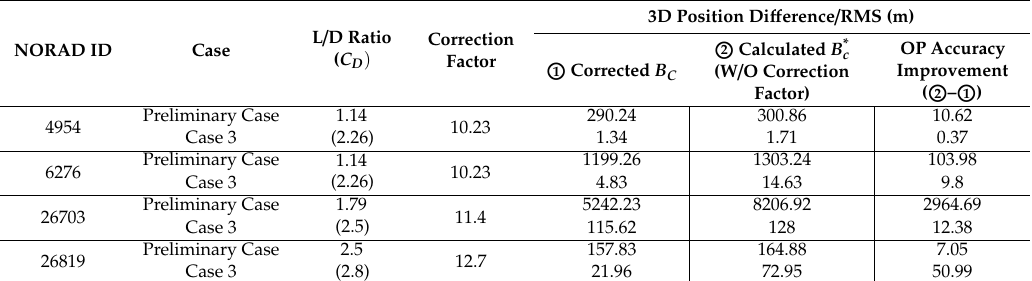
Table 10. The 3D position di ff erence RMS of preliminary case and Case